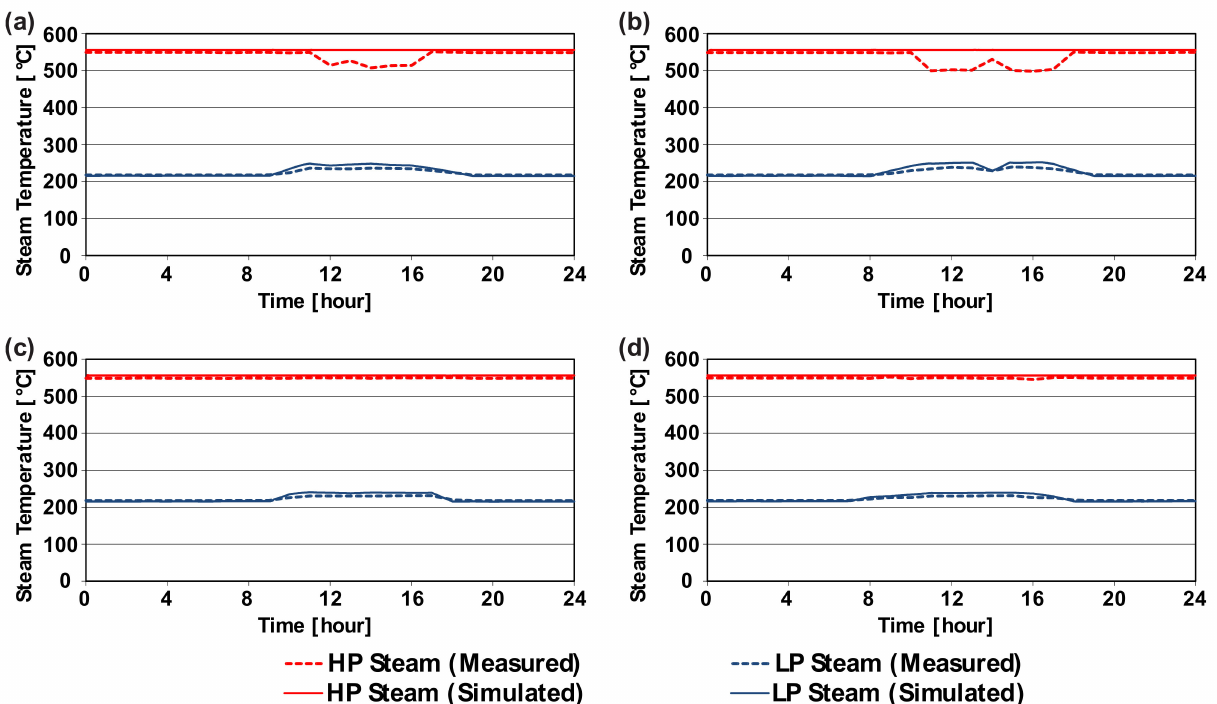
Figure 11. The steam temperature before the steam turbines for four days: ( a ) 20 July 2013; ( b ) 21 July 2013; ( c ) 30 August 2013 and ( d ) 4 September